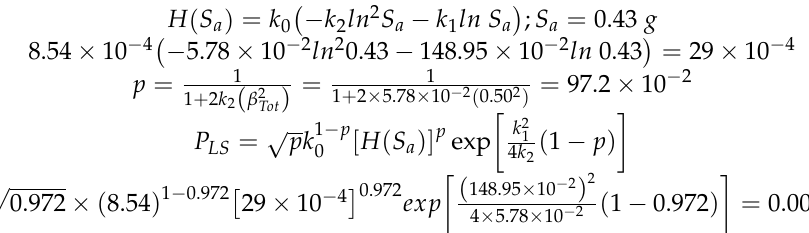
Figure A2. Wellington 1.0 s spectral acceleration hazard curve and fit curve as per recommendation by Vamvatsikos [16].